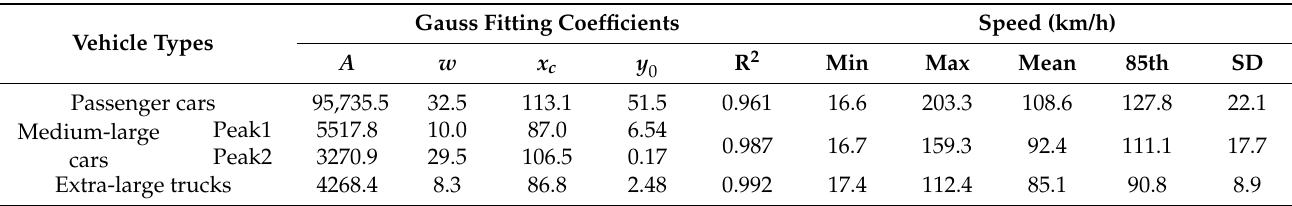
Table 4. Basic information on speed and the coefficients of curve